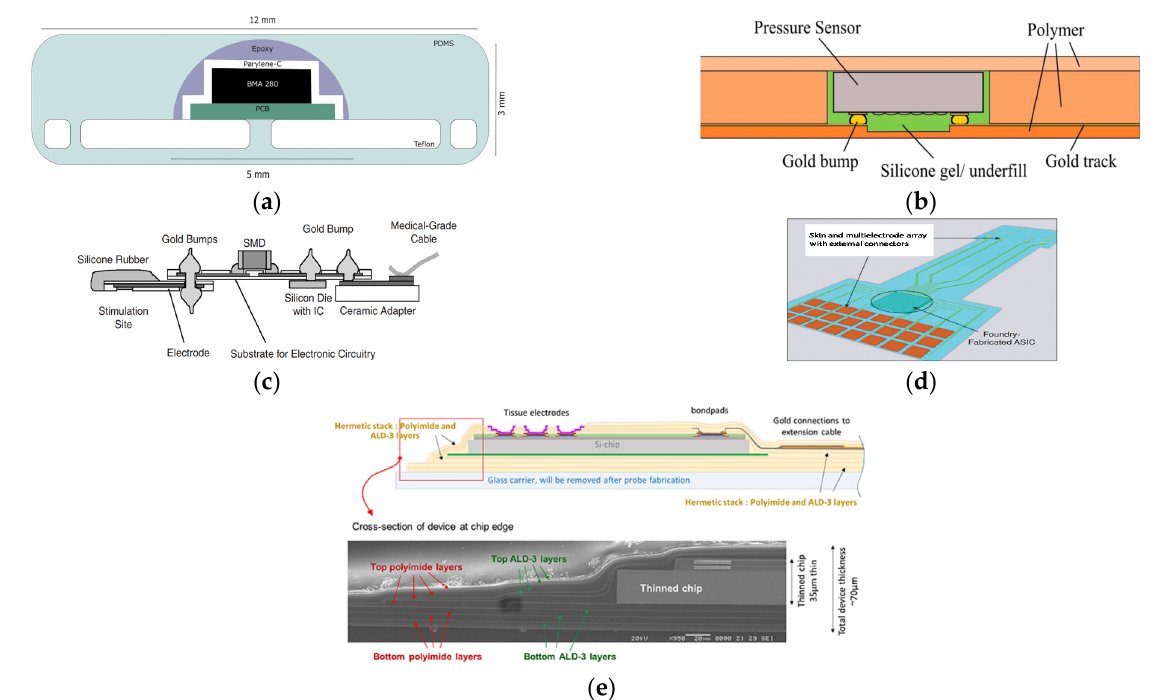
Figure 1. Examples of implantable device packaging. ( a ) PDMS encapsulation of wire-bonded chip; ( b ) Polyimide encapsulation of flip-chipped Si chip; ( c ) MicroFlex Interconnect (MFI); ( d ) MicroFlex Interconnect (MFI); ( e ) Ultra-Thin-Chip (UTC) packaging.